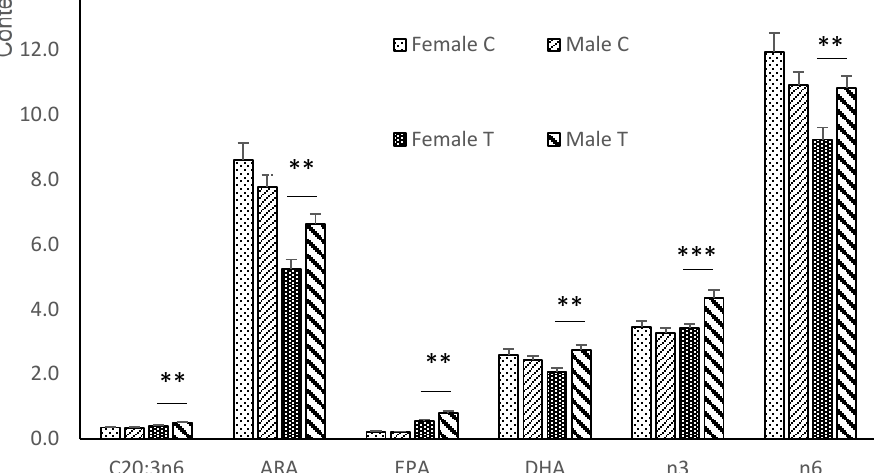
Figure 5. Treatment*sex interactions of the polar fraction of the liver in fetuses between fetuses obtained at 100 days of gestation born from control gilts (group C) or from gilts treated with hy- droxytyrosol and linseed oil from day 35 to day 100 of gestation (group T). ARA = arachidonic acid; EPA = eicosapentaenoic acid; DHA = docosahexaenoic acid; n3 = sum of n3-PUFA; n6 = sum of n6-PUFA. ** p < 0.01; *** p < 0.001.